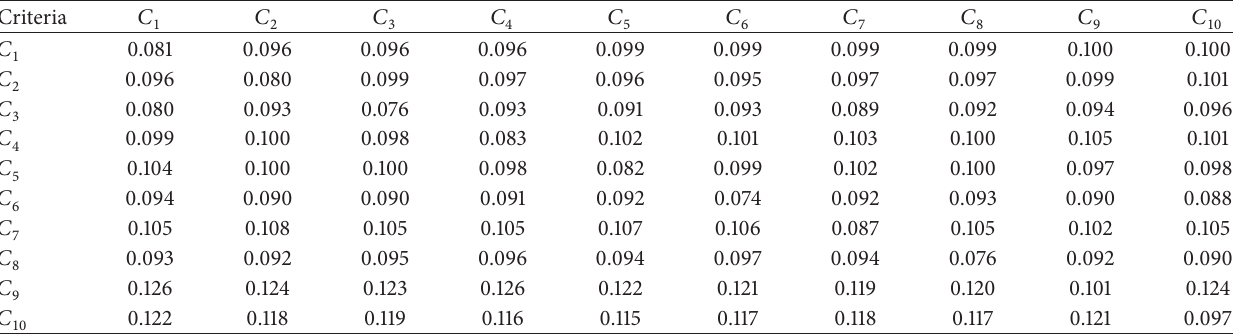
Table 6: The weighted supermatrix.